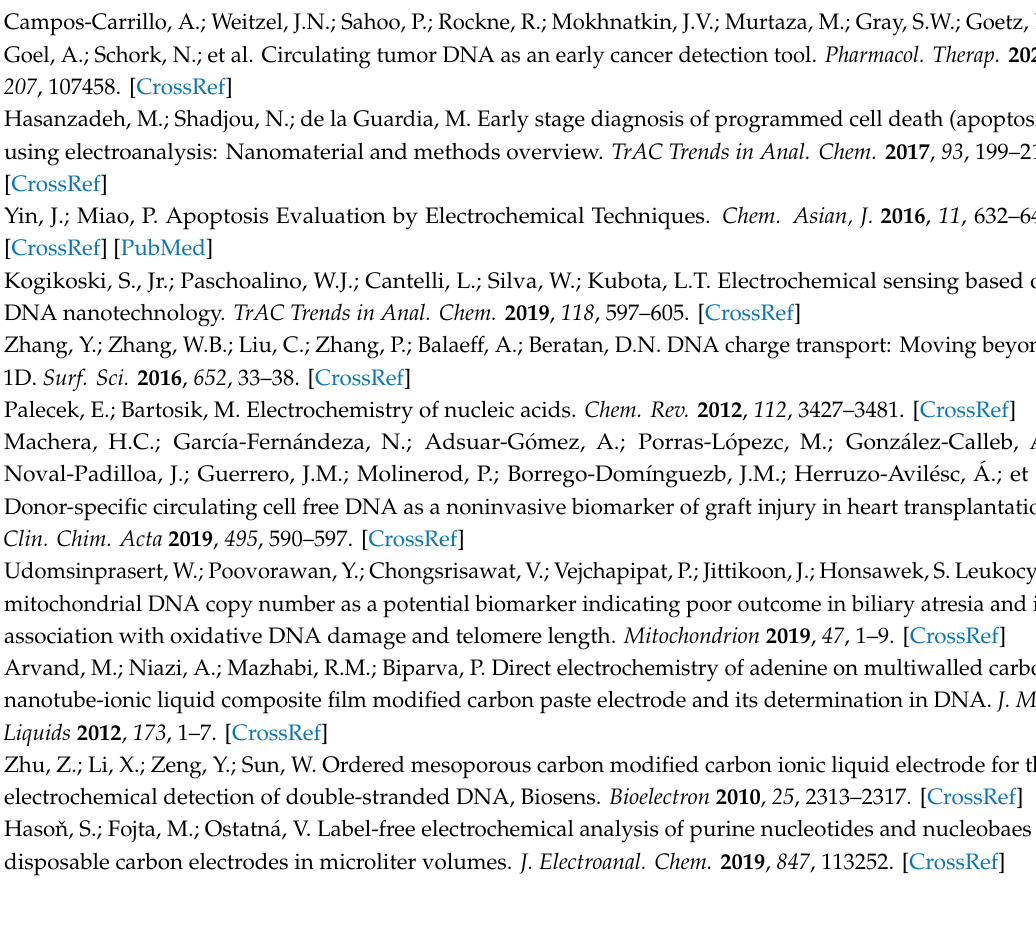
Figure S1–S2: 1 H-NMR spectra of P n BMA 40 -Br and P n BMA 40 - b -PDMAEMA 40 . Figure S3: The